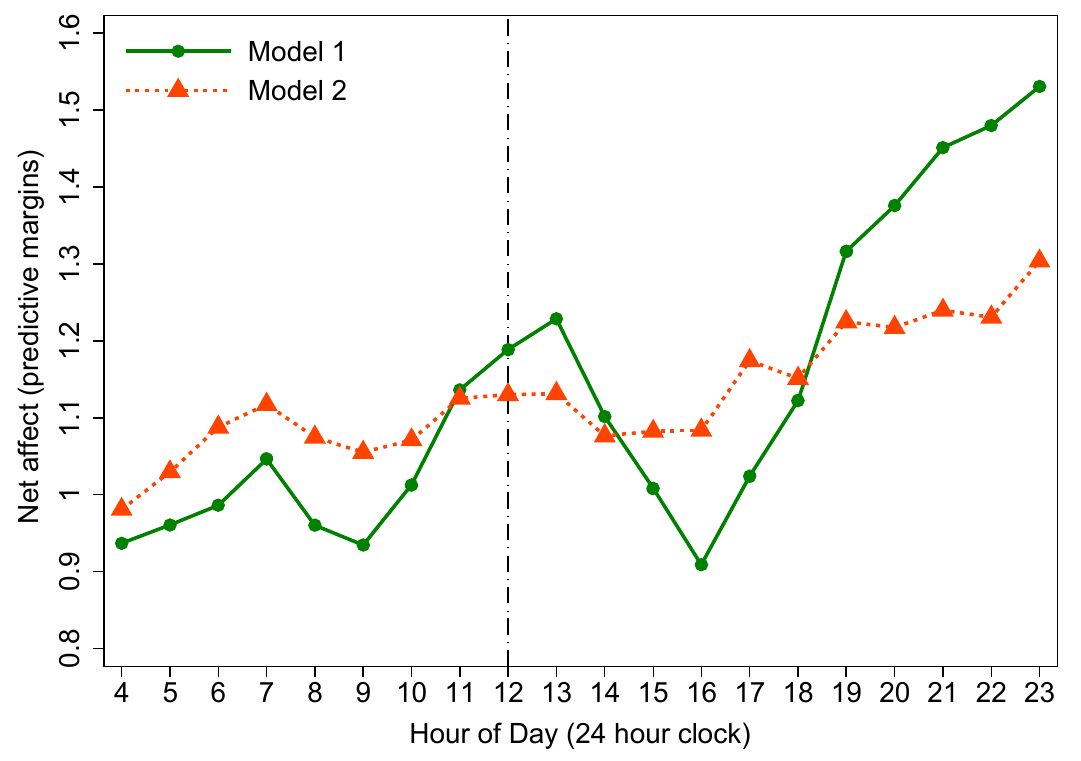
Figure 3. Diurnal rhythm of net affect (reference group: 4:00).